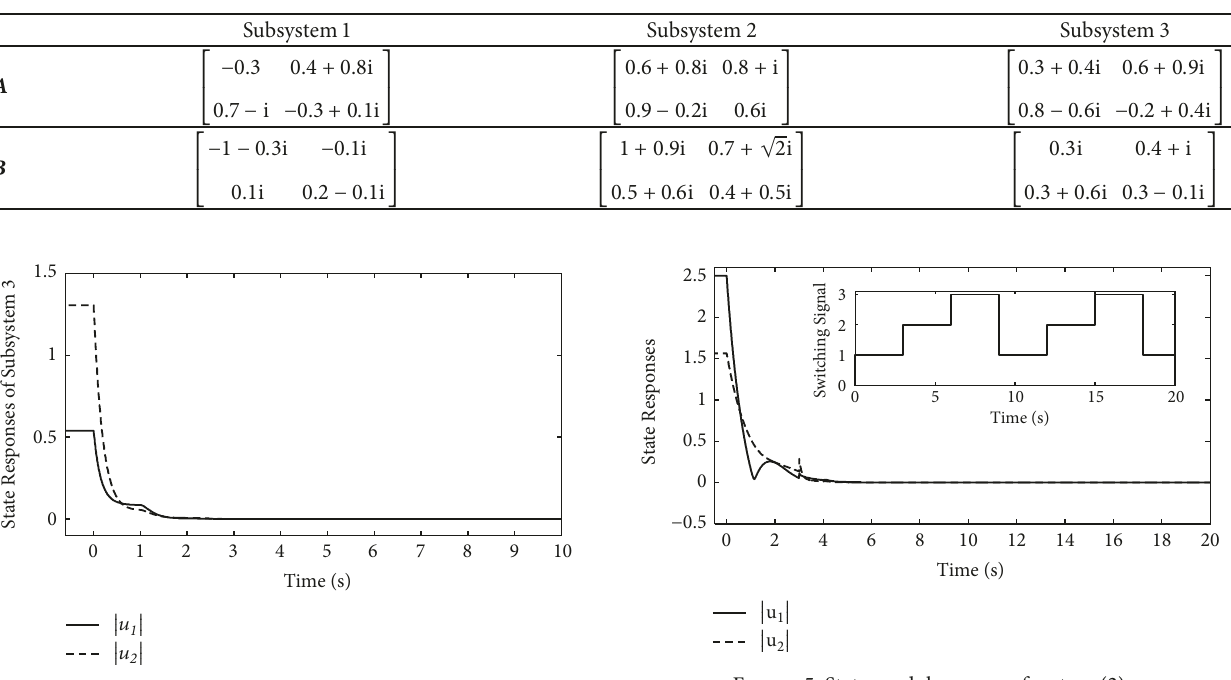
Figure 5: State module curves of system (2).